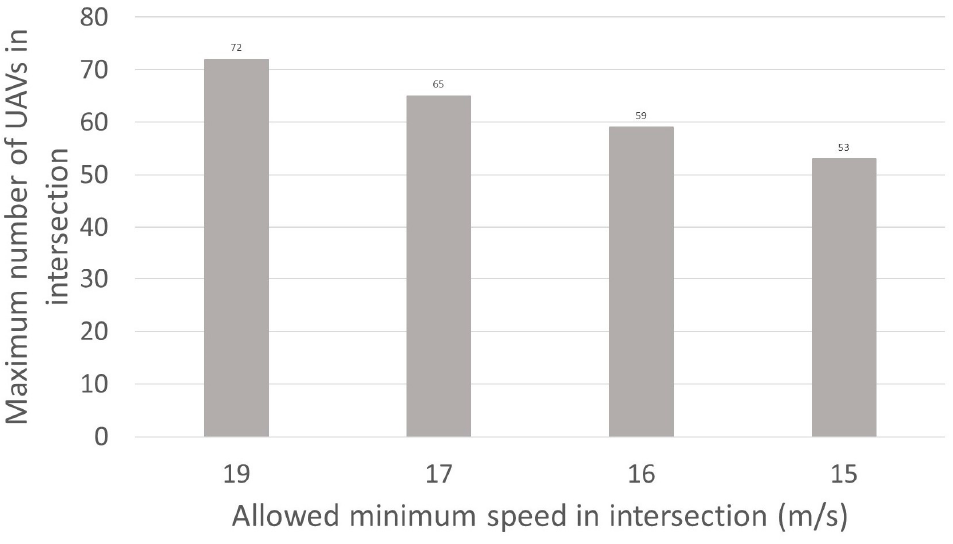
Figure 31. Maximum number of UAVs in the intersection when s max = 19 m/s for different values of s min .